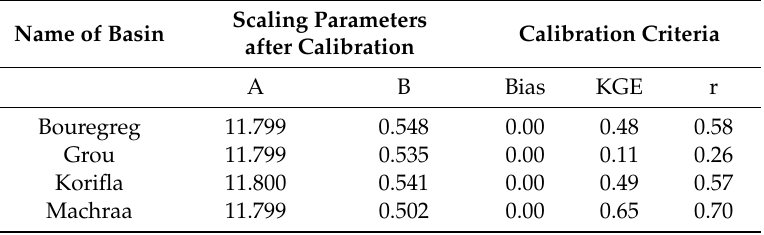
Table 12. Model calibration results at the four stations studied by percentage bias method